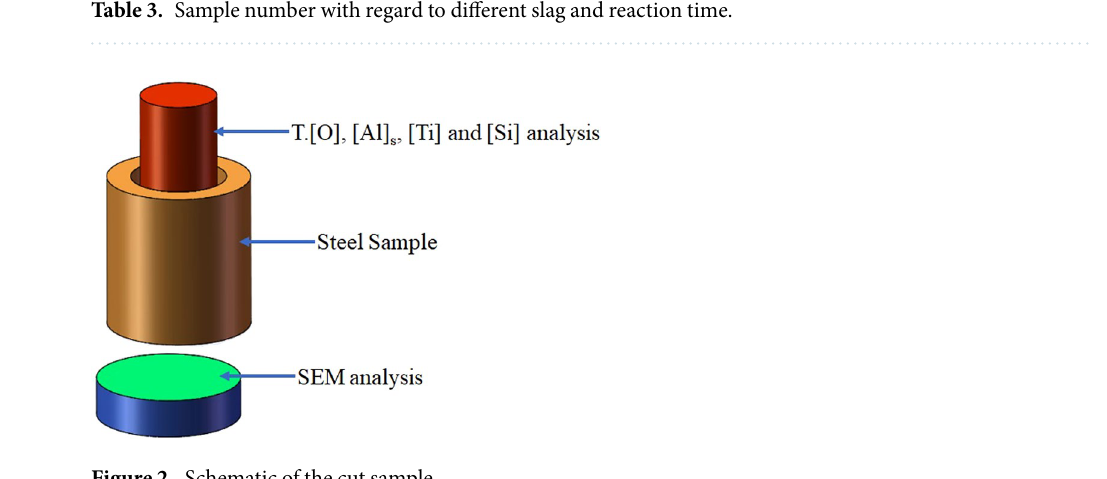
Figure 2. Schematic of the cut